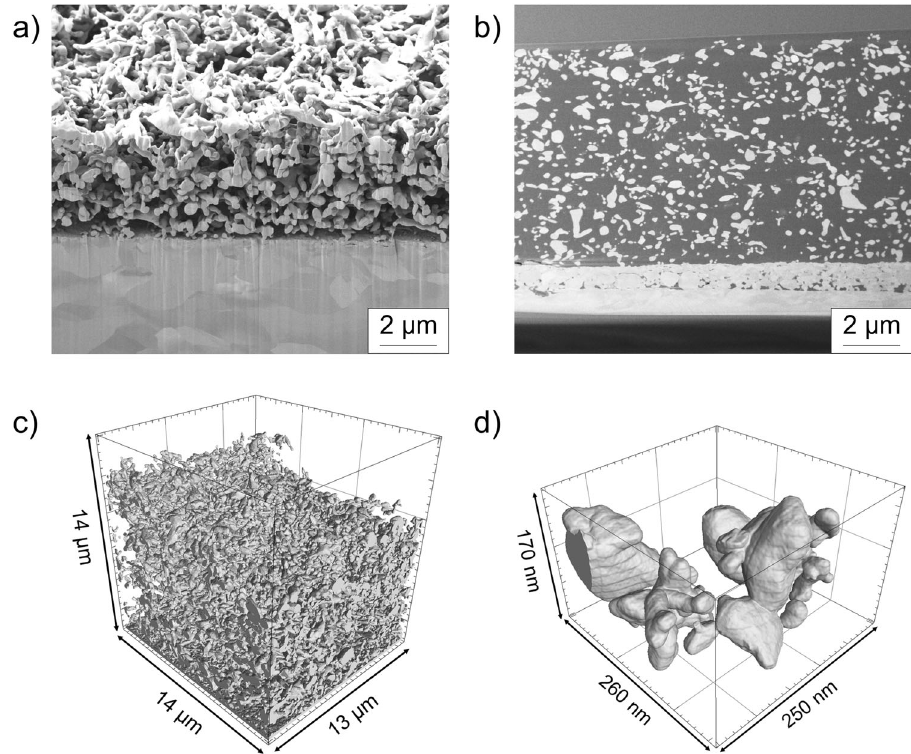
Fig. 8 Microstructure of nano-porous foam walls. a FIB-SEM, Ag foam, deposited with 0.25 Acm − 2 for 40 s, not embedded in resin, b FIB-SEM, Ag foam, deposited with 0.25 Acm − 2 for 40 s embedded in resin, c 3D reconstruction of a foam deposited with 0.5 Acm − 2 for 80 s, d enlargement of c , single particles of the